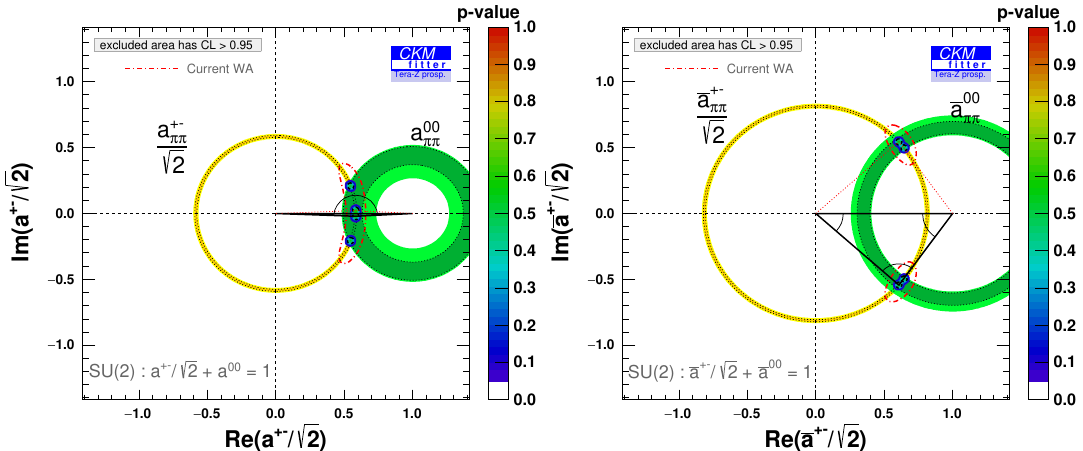
Figure 18 . Isospin triangles for B → ππ ( B 0 , B + modes on the left, scenario 2 improving both neutral and charged modes. We take the baseline value a 00